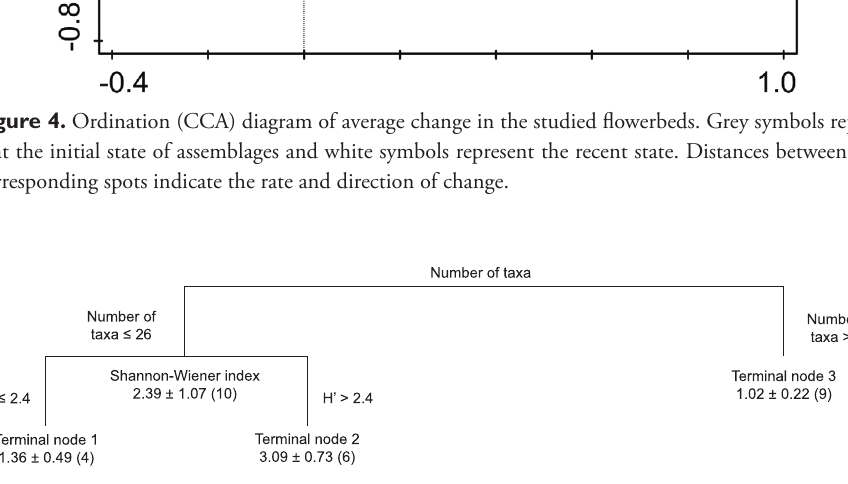
Figure 5. A regression tree showing the effects of number of taxa and Shannon-Wiener index (H’). Mean, standard deviation and number of observations are shown below each